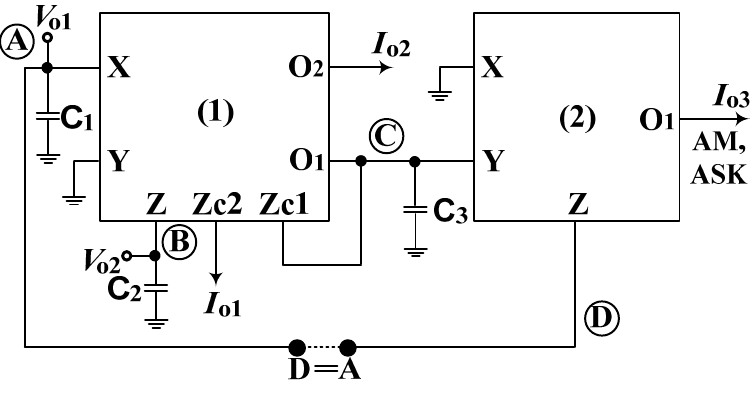
Figure 3. The proposed third-order quadrature sinusoidal oscillator.